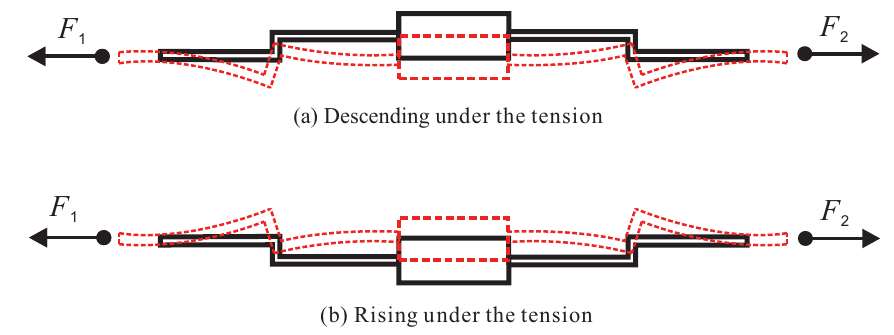
Figure 1. Z-shaped flexure hinge bending deformation principle.